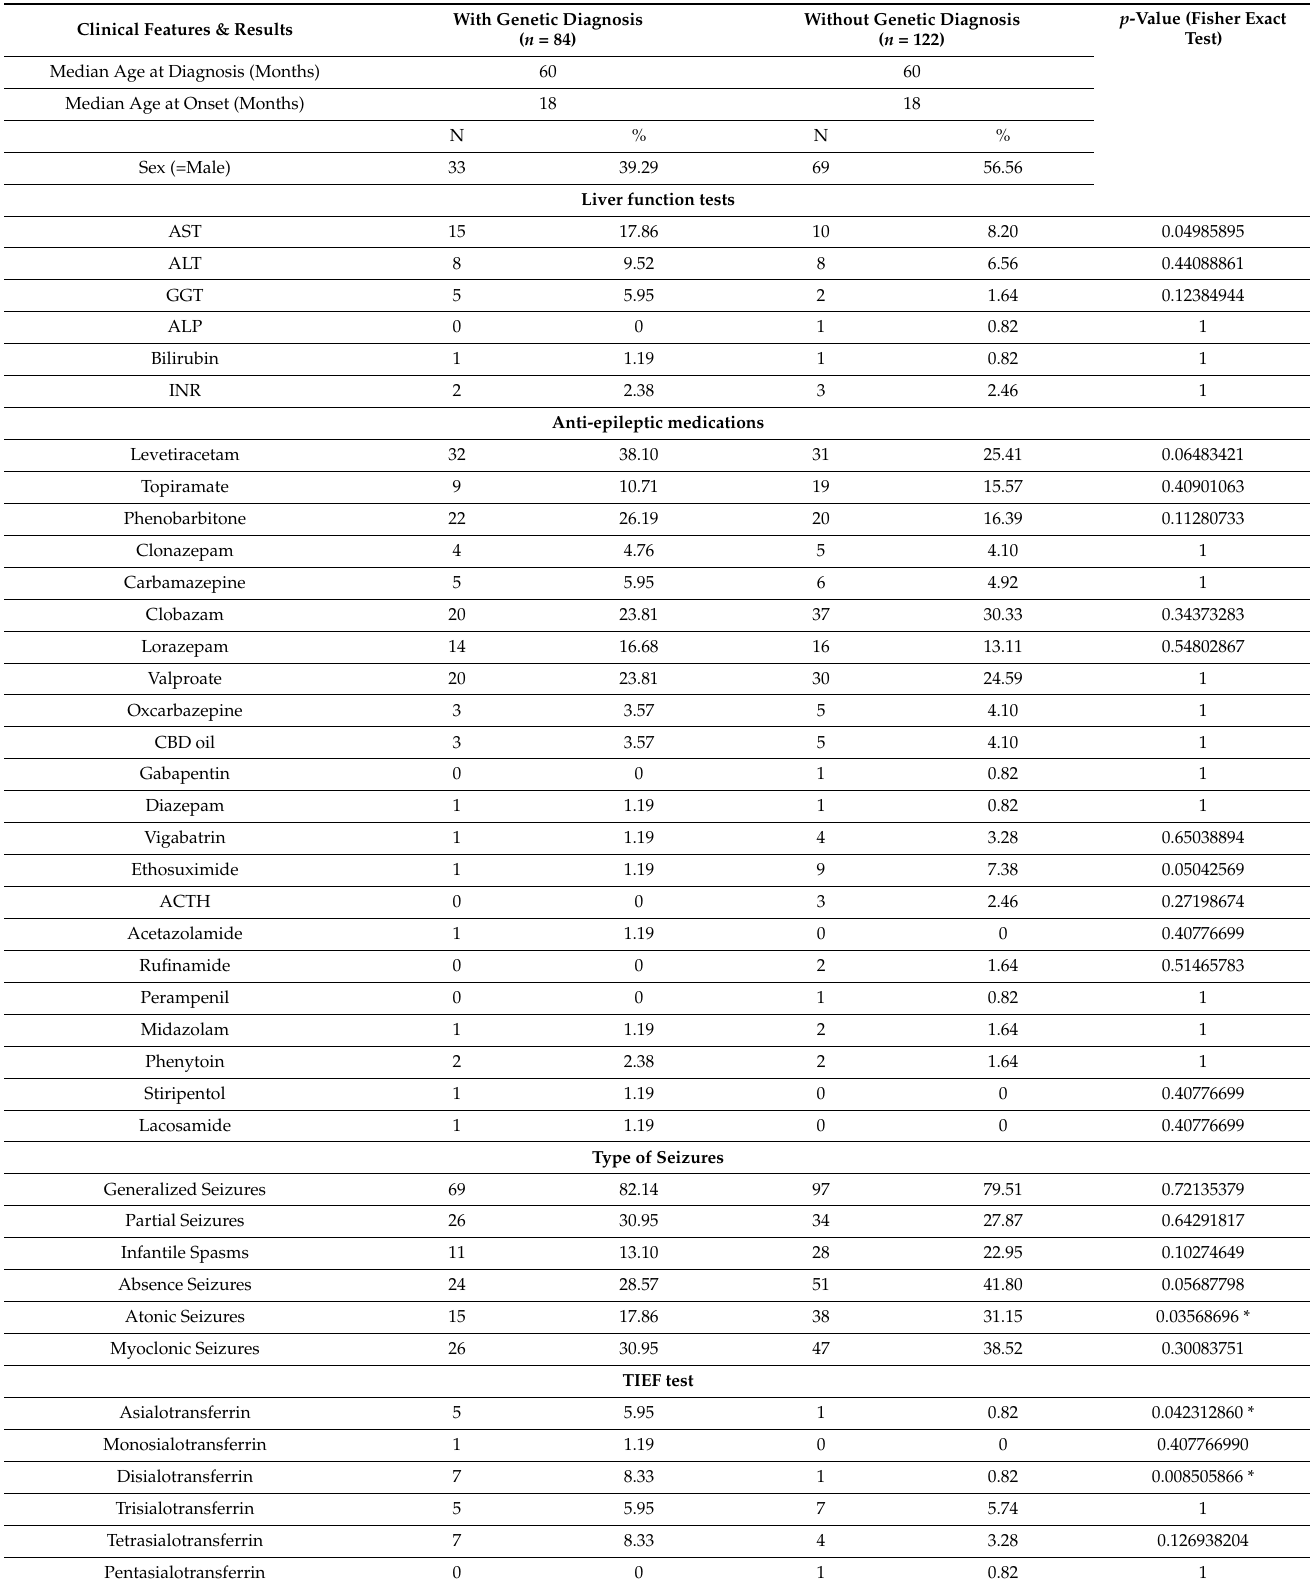
Table 3. Comparison of patients with and without a genetic diagnosis for their demographics, seizure types, anti-epileptic medications, transferrin isoelectric focusing and liver